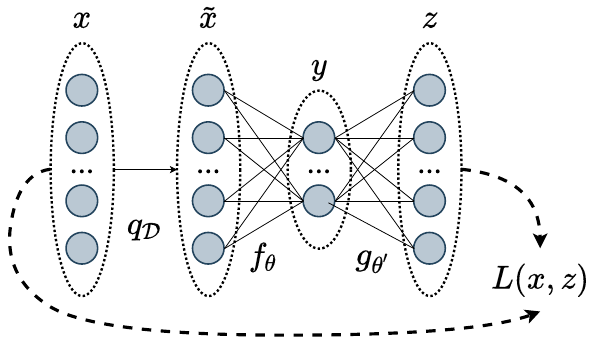
Fig. 1 Basic concept of denoising autoencoders. An input x is artifi- cially corrupted by some noise process q D to become ˜ x . The encoding portion of the autoencoder, f θ , produces a new representation y . The decoder portion of the network, g θ (cid:3) , attempts to reconstruct the clean input. Its estimate is given by z , and a loss function, L ( x , z ) ,